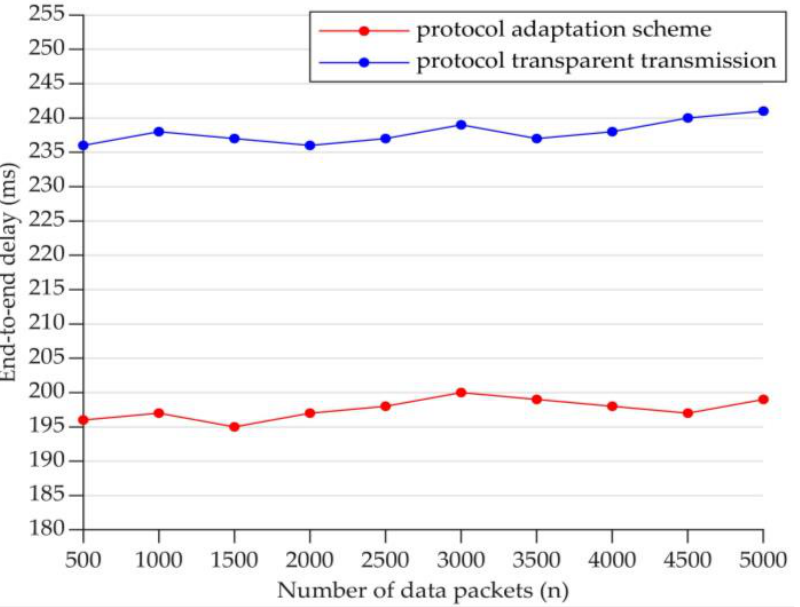
Figure 16. The end-to-end delay comparison between protocol adaptation and prototype transparent transmission for Modbus RTU.